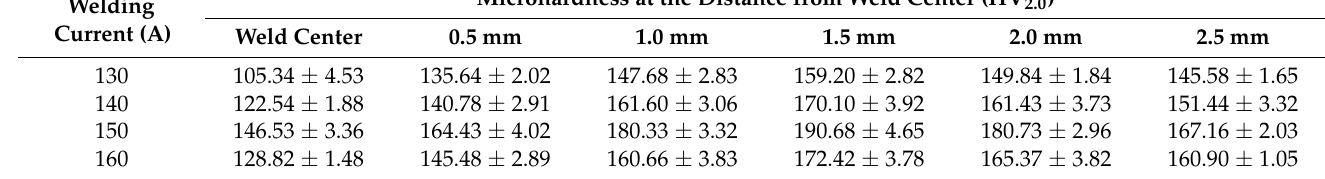
Table A2. Microhardness of the Cu35Ni25Co25Cr15 HEA coatings deposited under different welding currents.